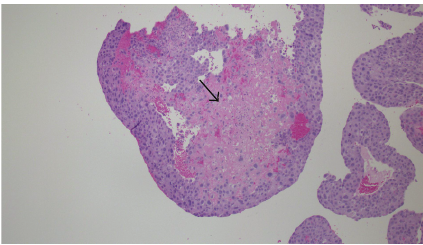
Figure 3: Tumor cells surrounded by eosinophilic hyaline-like material